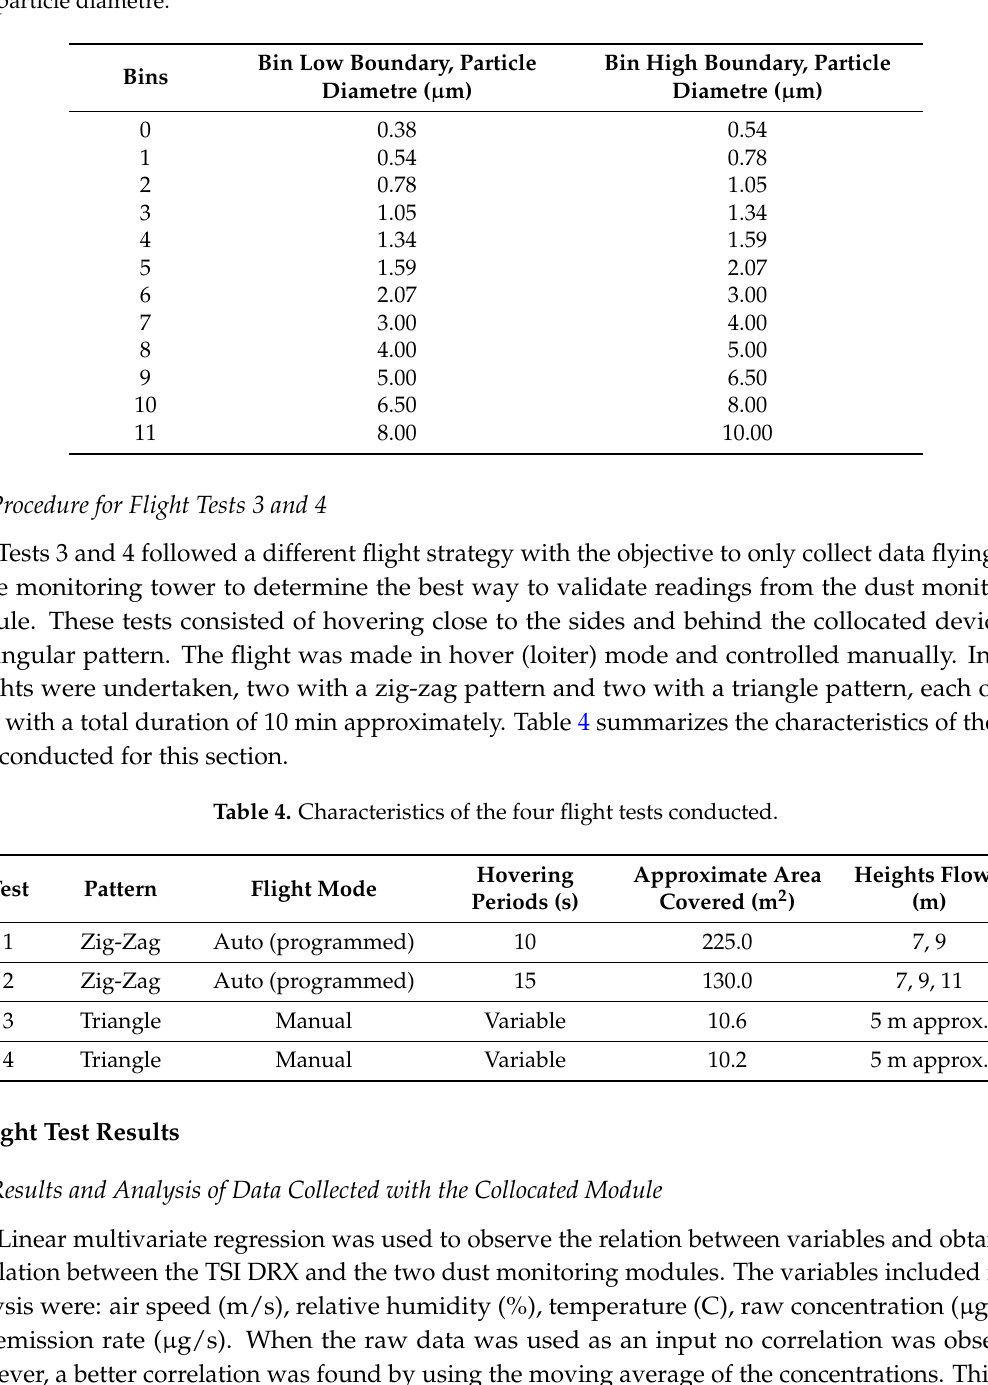
Table 3. Bins considered to calculate PM 10 concentrations and their boundaries according to particle diametre.